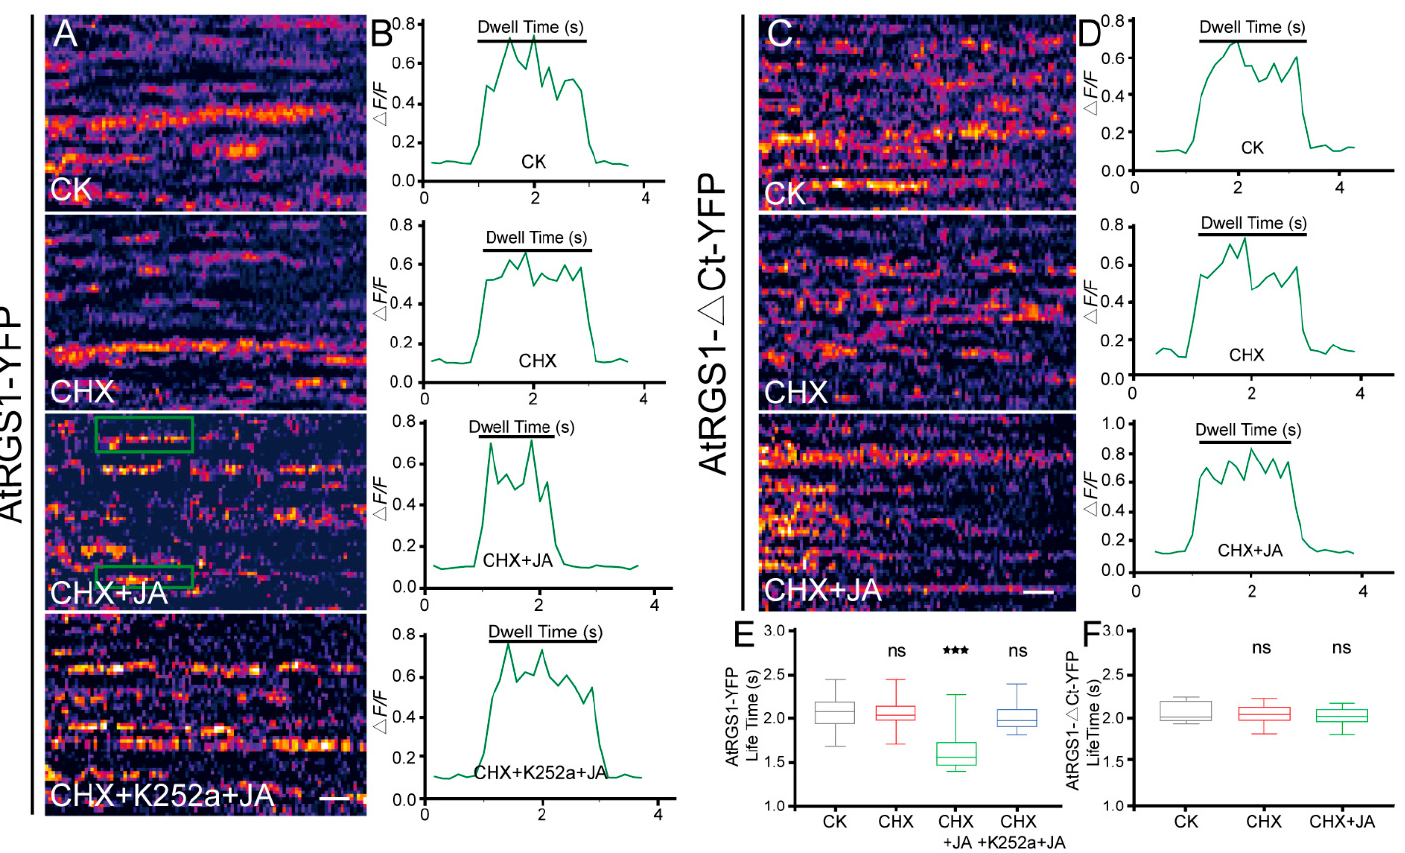
Figure 6. JA treatment a ff ects the dwell time of AtRGS1. ( A ) and ( C ), Representative kymograph showing individual AtRGS1-YFP ( A ) and AtRGS1- ∆ Ct-YFP ( C ) dwell times without treatment (CK), with CHX treatment, with MeJA treatment for 8 h plus CHX pretreatment, and with MeJA treatment for 8 h plus CHX and K252a pretreatment. Bar = 0.5 s. ( B ) and ( D ), Representative traces of normalized fluorescence of AtRGS1-YFP ( B ) and AtRGS1- ∆ Ct-YFP ( D ) under di ff erent conditions as ( A ) and ( C ) by MATLAB analysis. ( E , F ), The average dwell time of AtRGS1-YFP ( E ) and AtRGS1- ∆ Ct-YFP ( F ) under the di ff erent treatment as ( A ) and ( C ). Error bars represent SD ( n = 10). Significant di ff erences are denoted by asterisks (*** p < 0.001, ns, no significant di ff erence, Student’s t